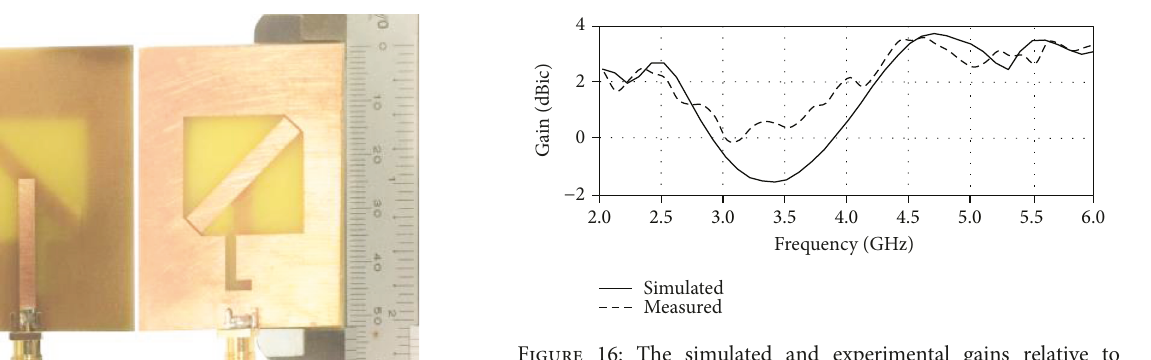
Figure 16: The simulated and experimental gains relative to frequency of the proposed antenna.